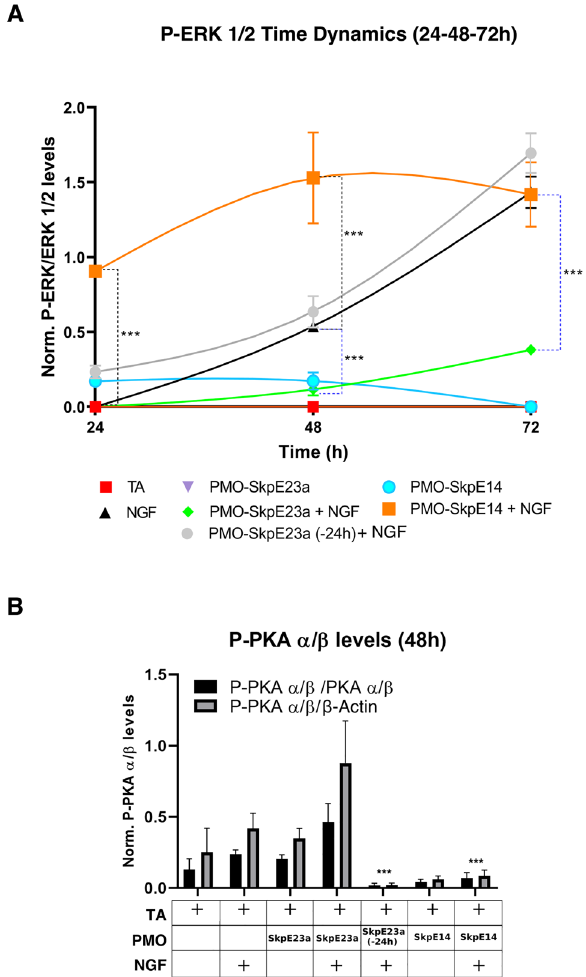
Figure 8. Effect on ERK and PKA activation of inducing NF1 isoform switch before NGF-triggered differentiation of PC12 cells. ( A ) Time course expression analysis by Western blot of P-ERK1/2 levels normalized to total ERK1/2 levels using different PMOs and PMO conditions. Differences between PMO- SkpE23a added 24 h before NGF treatment (-24 h), PMO-SkpE23a and PMO-SkpE14 added at the same time as NGF treatment were evaluated by paired t -test versus cells treated only with NGF. Each point represents the Mean ± SEM. *** P < 0.001. ( B ) Expression analysis by Western blot and quantification of P-PKA and total PKA using different PMOs and PMO conditions. Differences were evaluated by paired t -test versus cells treated only with NGF. Bars indicate Mean ± SEM. *** P < 0.001. Supporting whole gel images can be found in Supplementary Fig.